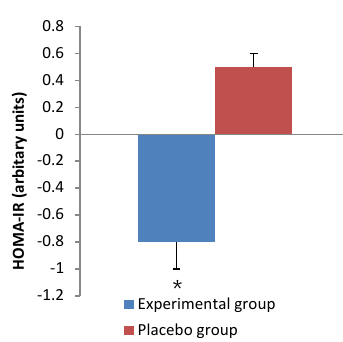
Figure 4. Change in insulin resistance over the intervention period. Values are expressed as mean ± SEM. * p < 0.05, compared with placebo group.